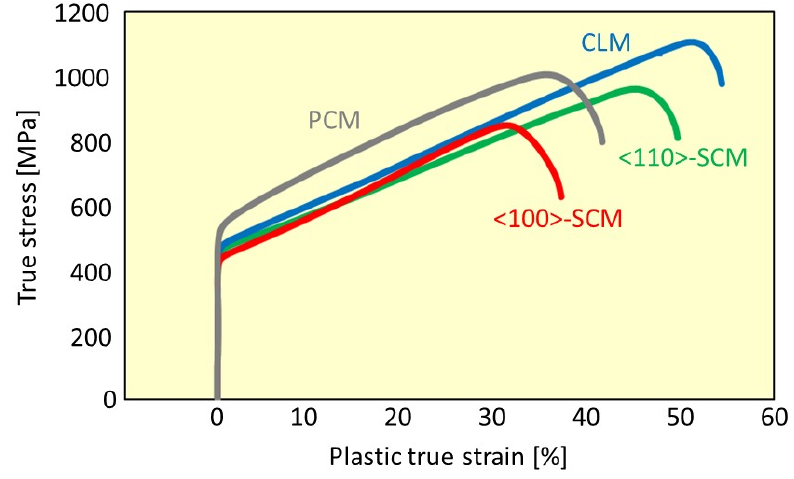
Figure 5. True stress–true strain curves of the four typical crystallographic textures. Table 2. Tensile properties of the four typical crystallographic textures and the requirement values in Hastelloy-X castings (AMS5390) and Hastelloy-X sheets (ASTM B435-06).